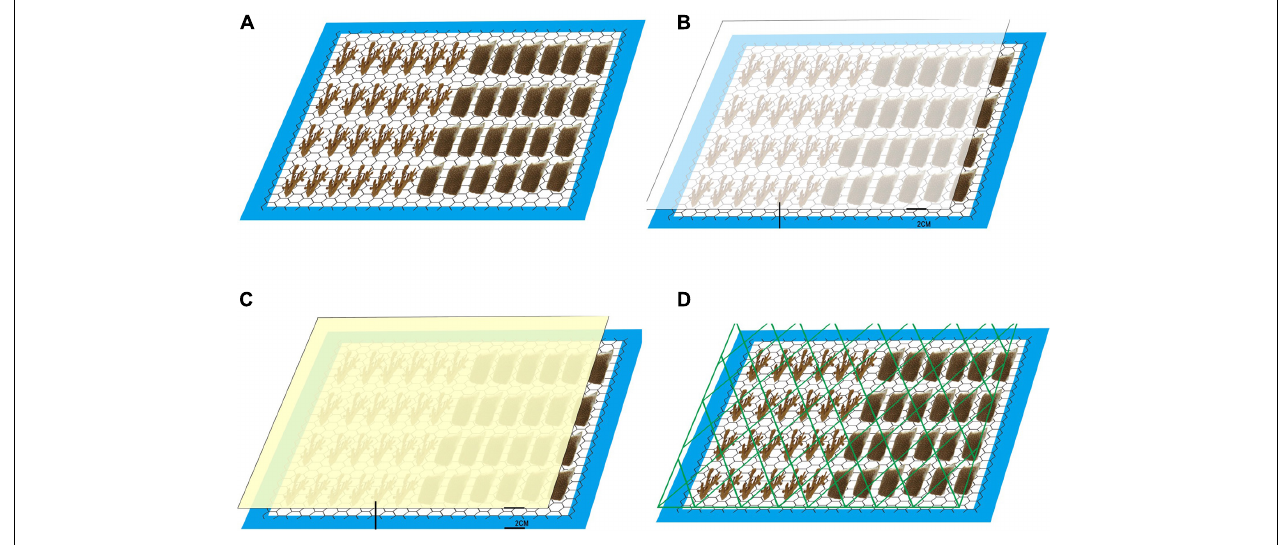
FIGURE 1 | Images of the experiment tank design. (A) Control, (B) Transparent bag, (C) Opaque bag, and (D) Fishing